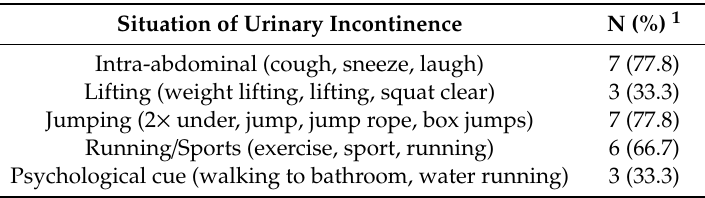
Table 3. Activities that have triggered urinary